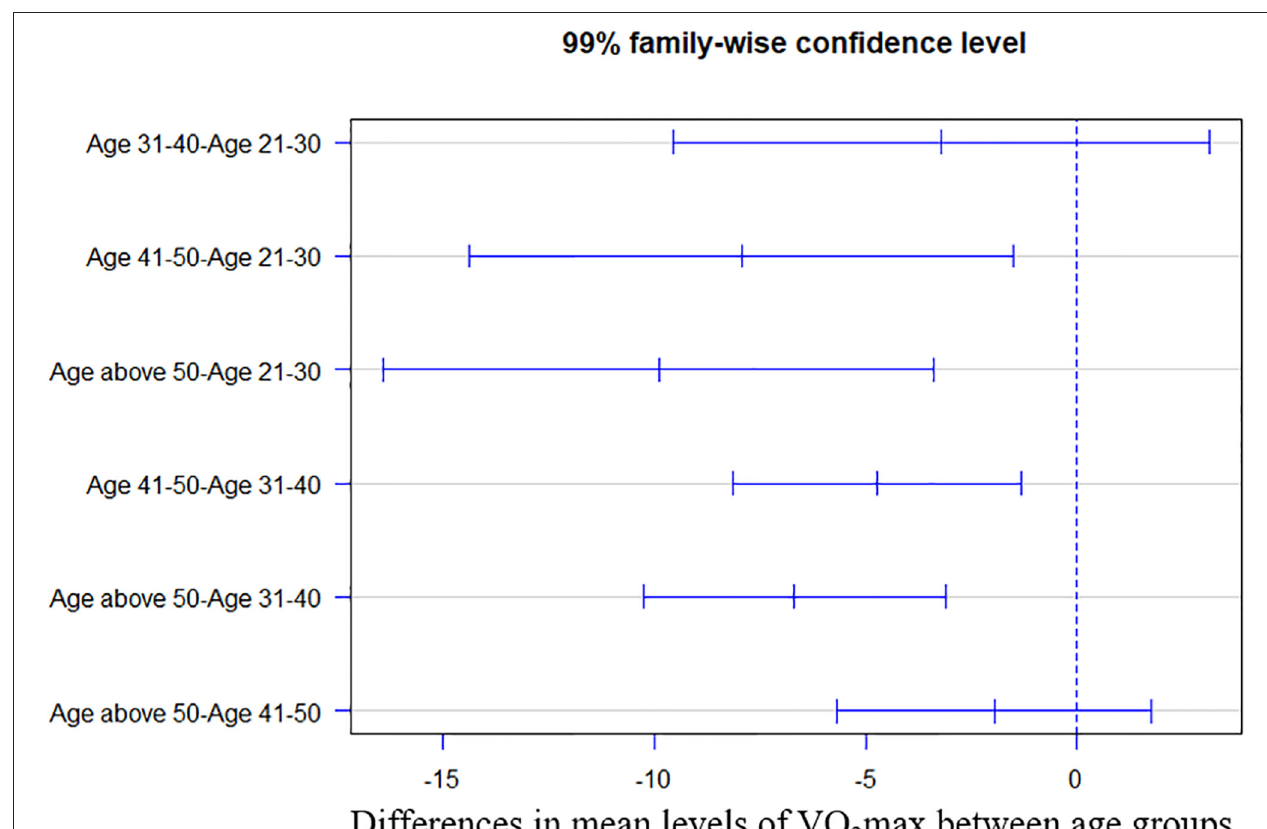
Table 2 . The accuracies of VO 2 max of the classifying participants into poor, average, good, and excellent categories were shown in the confusion matrix ( Figure 2 ). The X-axis showed the actual level of VO 2 max, while the Y-axis depicted the predicted VO 2 max utilizing an SVM classifier, and values were normalized to present the percentage of each class. The average level of